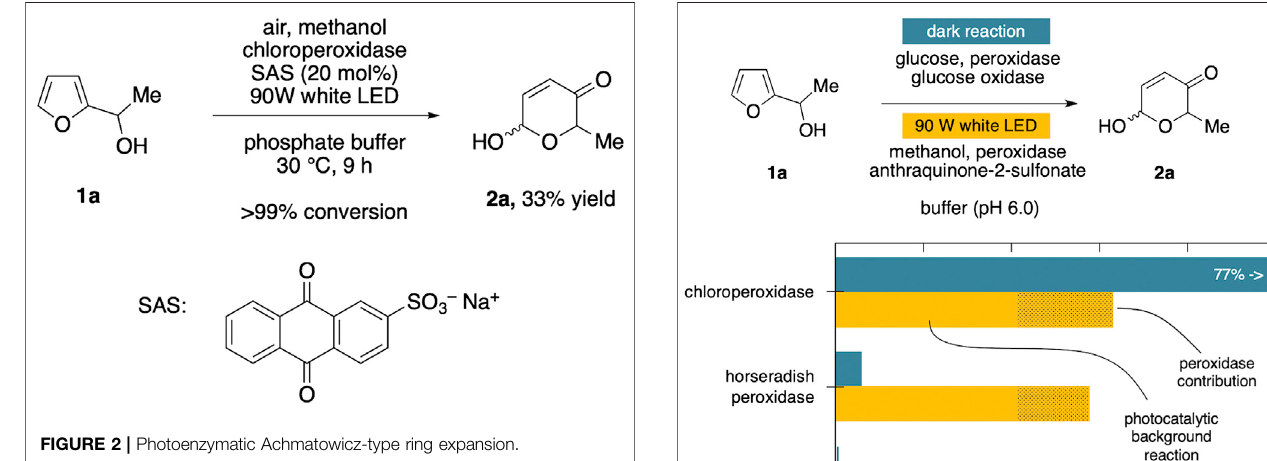
FIGURE 2 | Photoenzymatic Achmatowicz-type ring expansion.